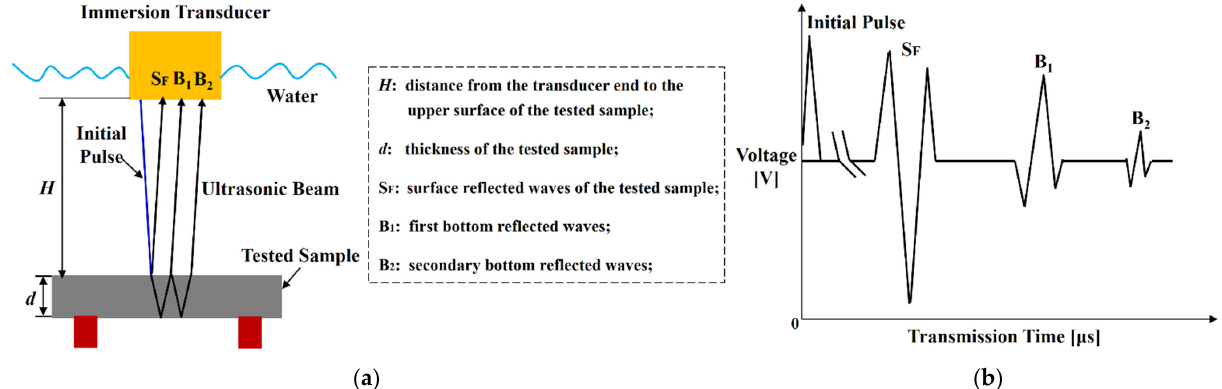
Figure 1. Schematic diagram of the immersion pulse reflection method: ( a ) the transmission process of ultrasonic waves; ( b ) the transmission time of ultrasonic waves.